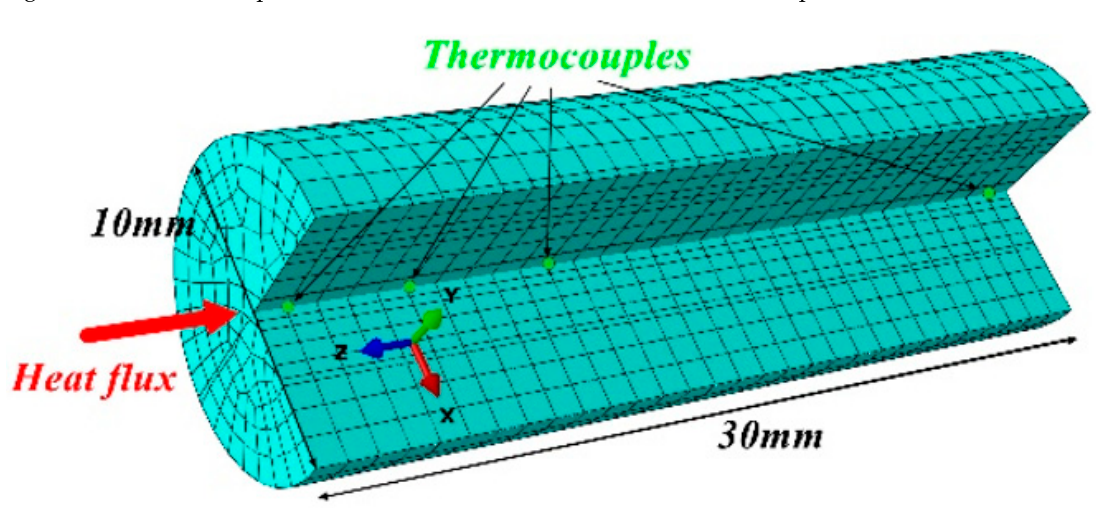
Figure 2. Finite element model of the test sample.